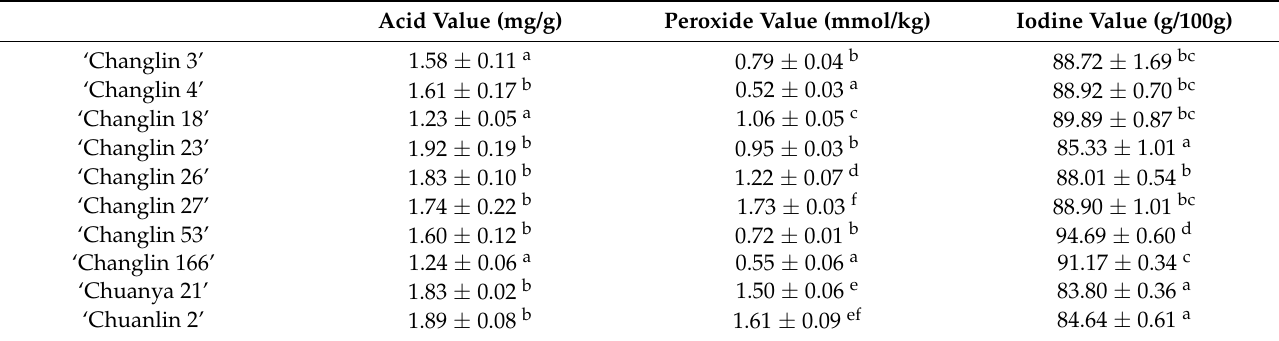
Table 1. Acid, peroxide and iodine values in C. oleifera oil from ten cultivars. Acid Value (mg/g)